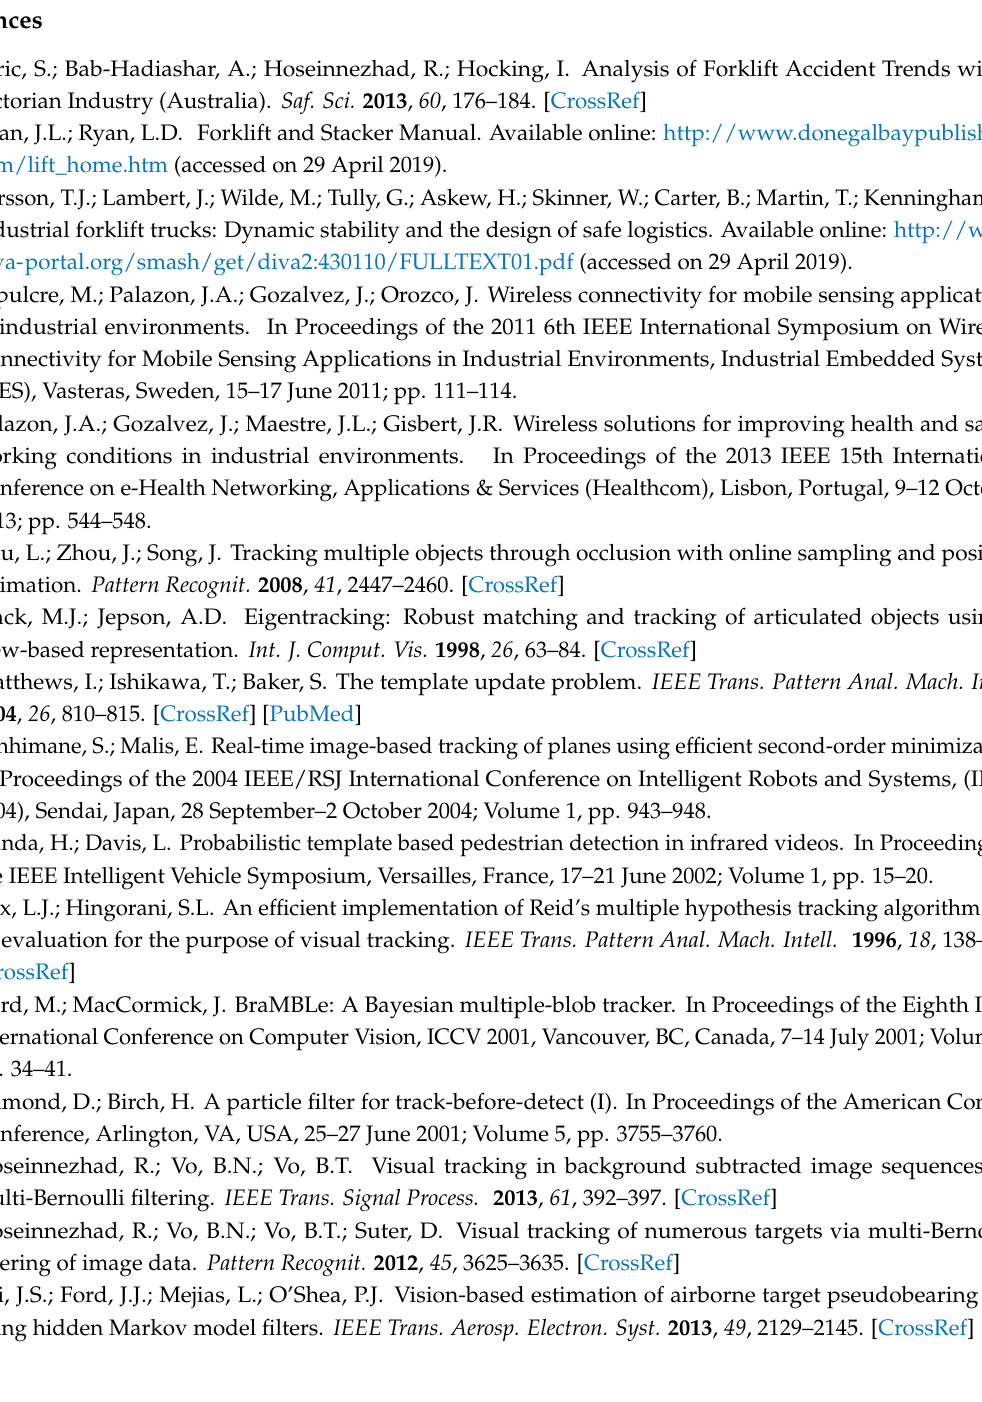
our trackers mostly outperform state-of-the-art in terms of false alarm rate, false negative rate, label switching errors, and losing